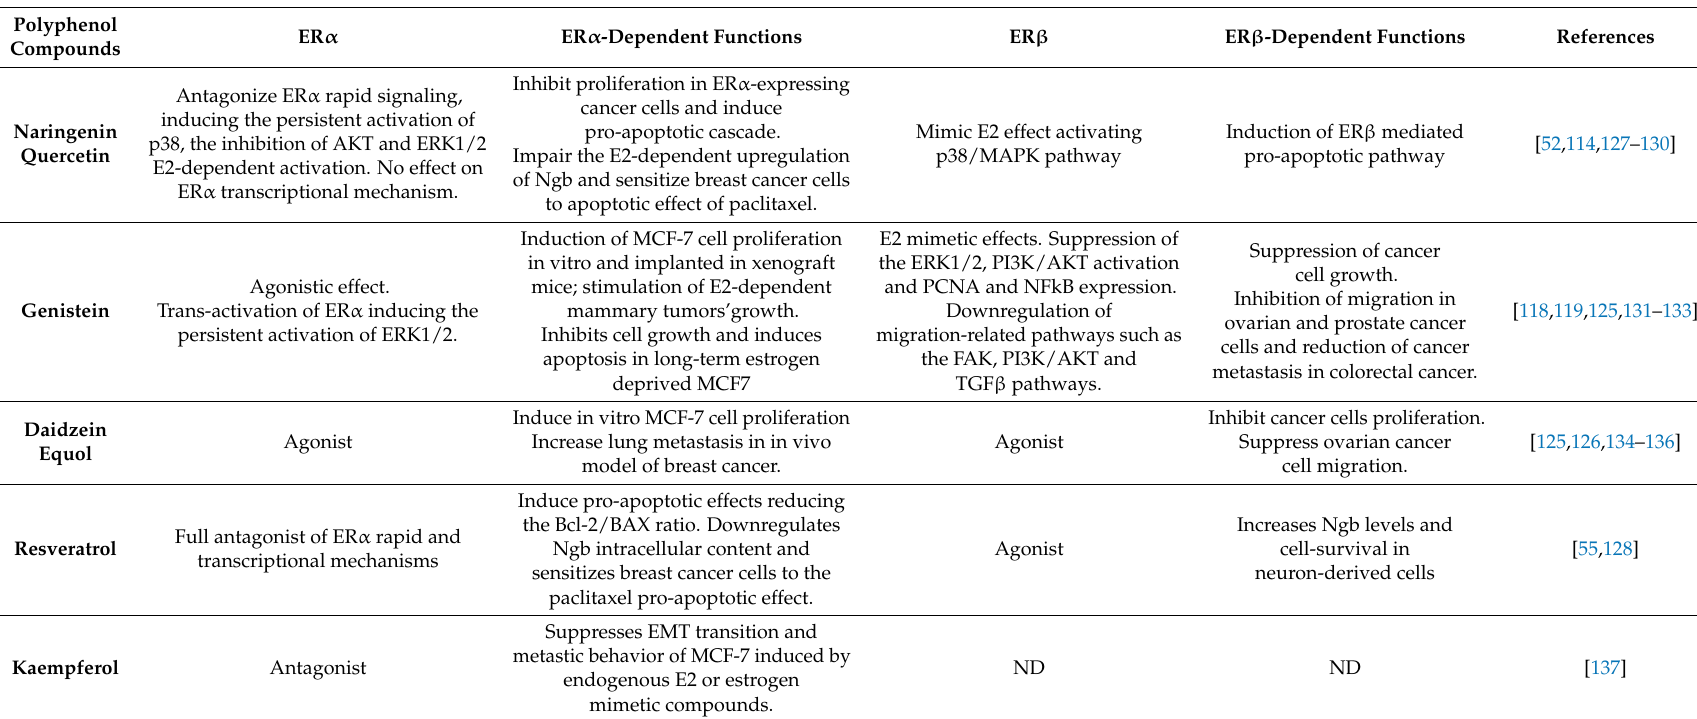
Table 1. Summary of known effects of dietary polyphenols on cancer hallmarks through estrogen receptor subtype (ER α or ER β )-mediated molecular mechanisms. Polyphenol